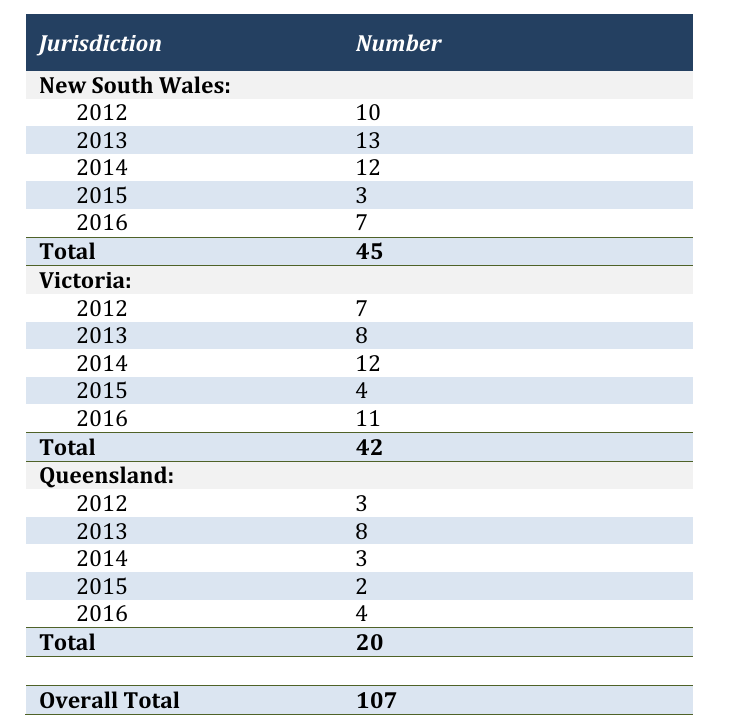
Table 1: Criminalisation statutes passed for New South Wales, Victoria and Queensland (2012 ‐ 2016)